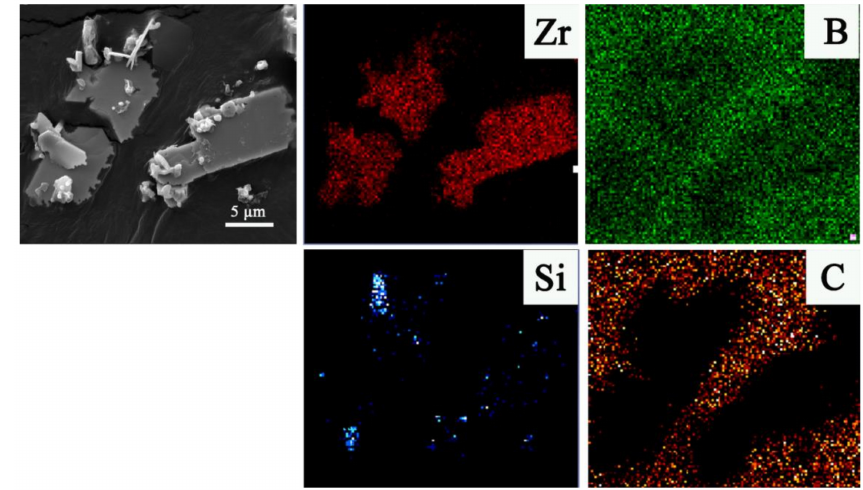
Figure 4. A lower magnification SEM image with EDS mapping of as-prepared ZrB 2 -SiC powders fired at 1250 ◦ C for 20 min with 60 mol % excess B 4 C and a salt-medium/reactant weight ratio of 2.0.